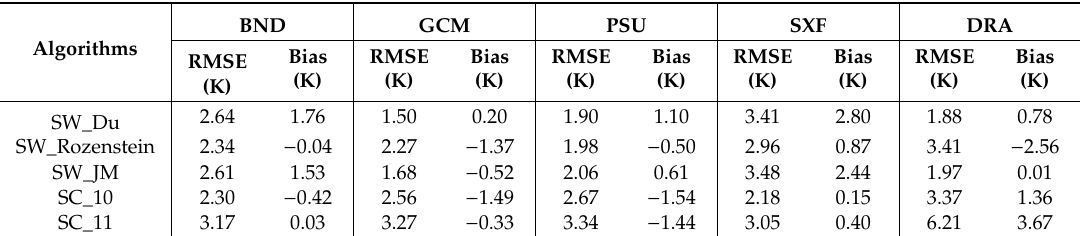
Table 6. The RMSE and bias of the LST retrieved from Landsat 8 TIRS images on five sites before the stray light correction.